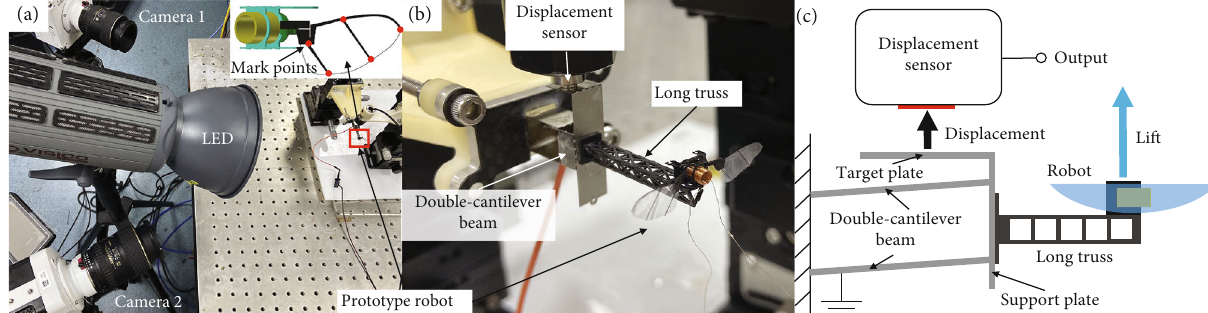
Figure 6: (a) Setup of the lift measurement for the designed robot. (b) Photo of the measurement with two high-speed cameras. (c) Schematic of the customized lift measurement